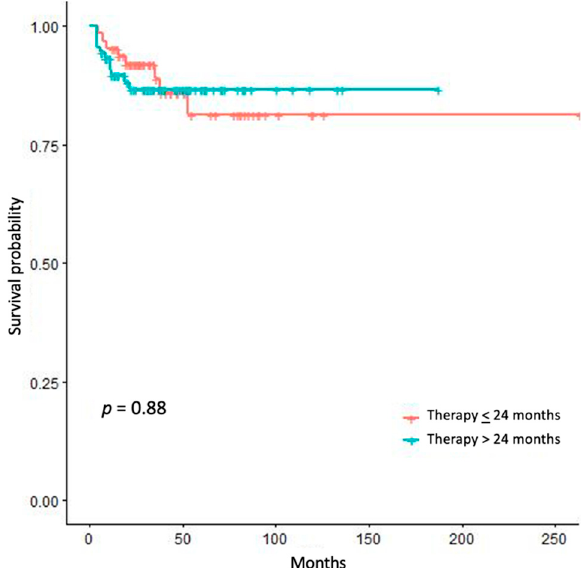
Figure 2. Kaplan–Meier estimates of recurrence-free survival (RFS) in patients treated <24 months versus patients treated >24 months.